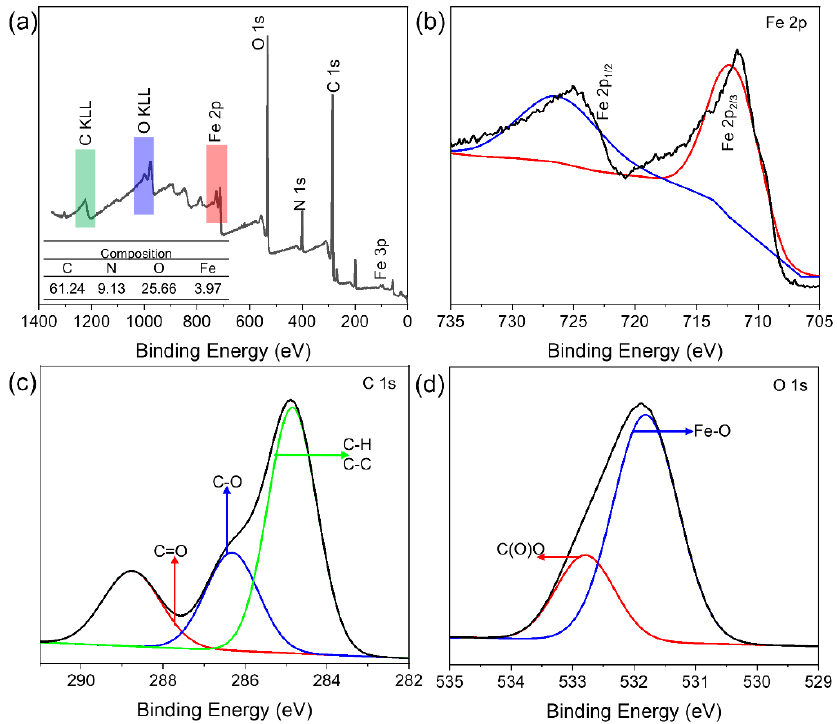
Figure 4. XPS spectra of the PAN-MIL101(Fe)-NH 2 : ( a ) broad spectrum, ( b ) Fe2p, ( c ) C1s, and ( d ) O1s spectra. ( d ) O1s